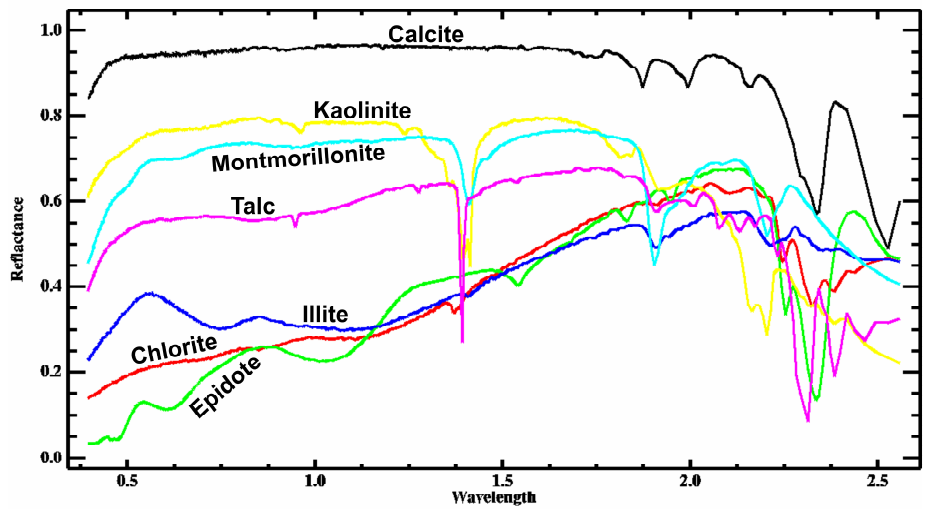
Figure 9. USGS spectral of kaolinite, montmorillonite, illite, chlorite, epidote, calcite and talc.